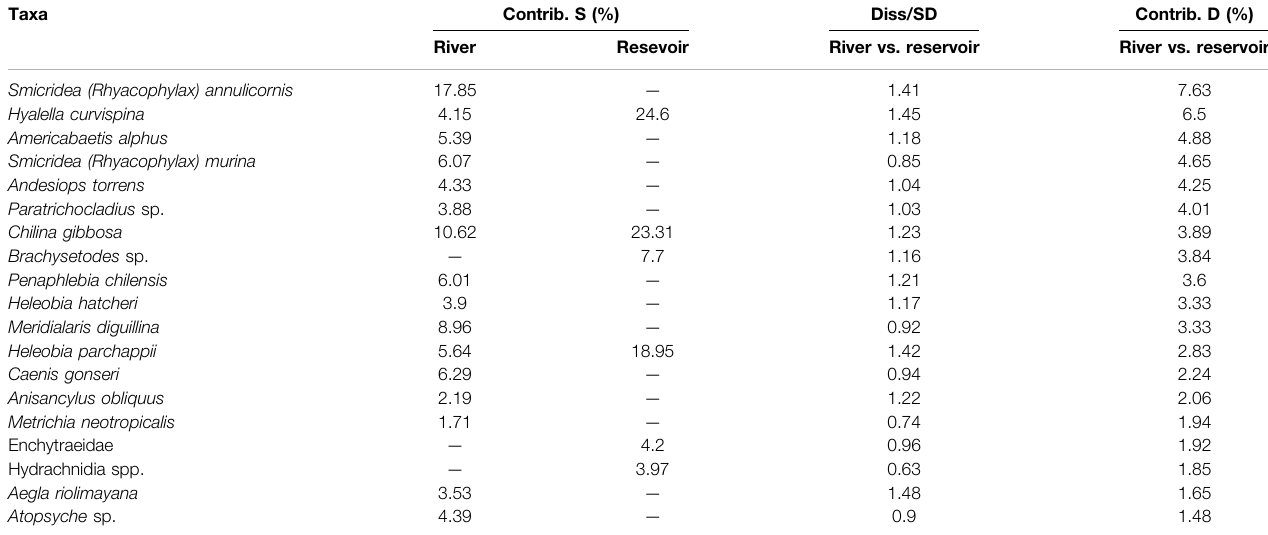
TABLE 5 | Summary of Similarity Percentage analysis (SIMPER) of macroinvertebrate, showing the organisms which most contributed to the observed differences among groups (river and reservoir). Contrib.S, contribution to the intragroup simillarity; Diss, mean disimillarity and their SD, standard deviation; Contrib.D, contribution to the intergroup